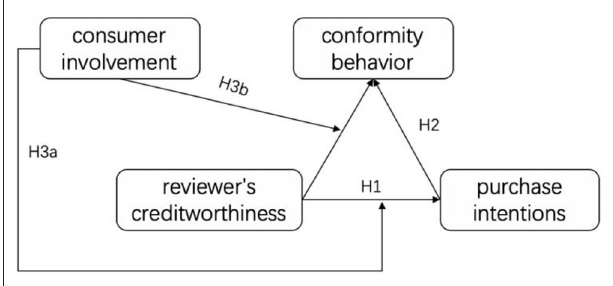
FIGURE 1 | Theoretical